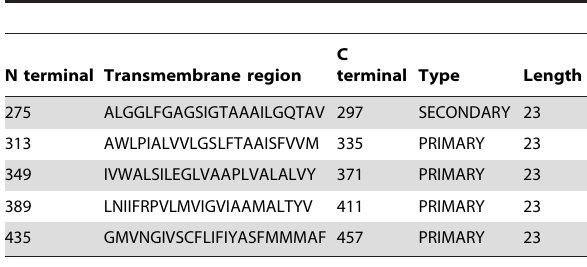
Table 3. BLASTX results for P. salmonis dotB, dotA, icmK and icmE genes.